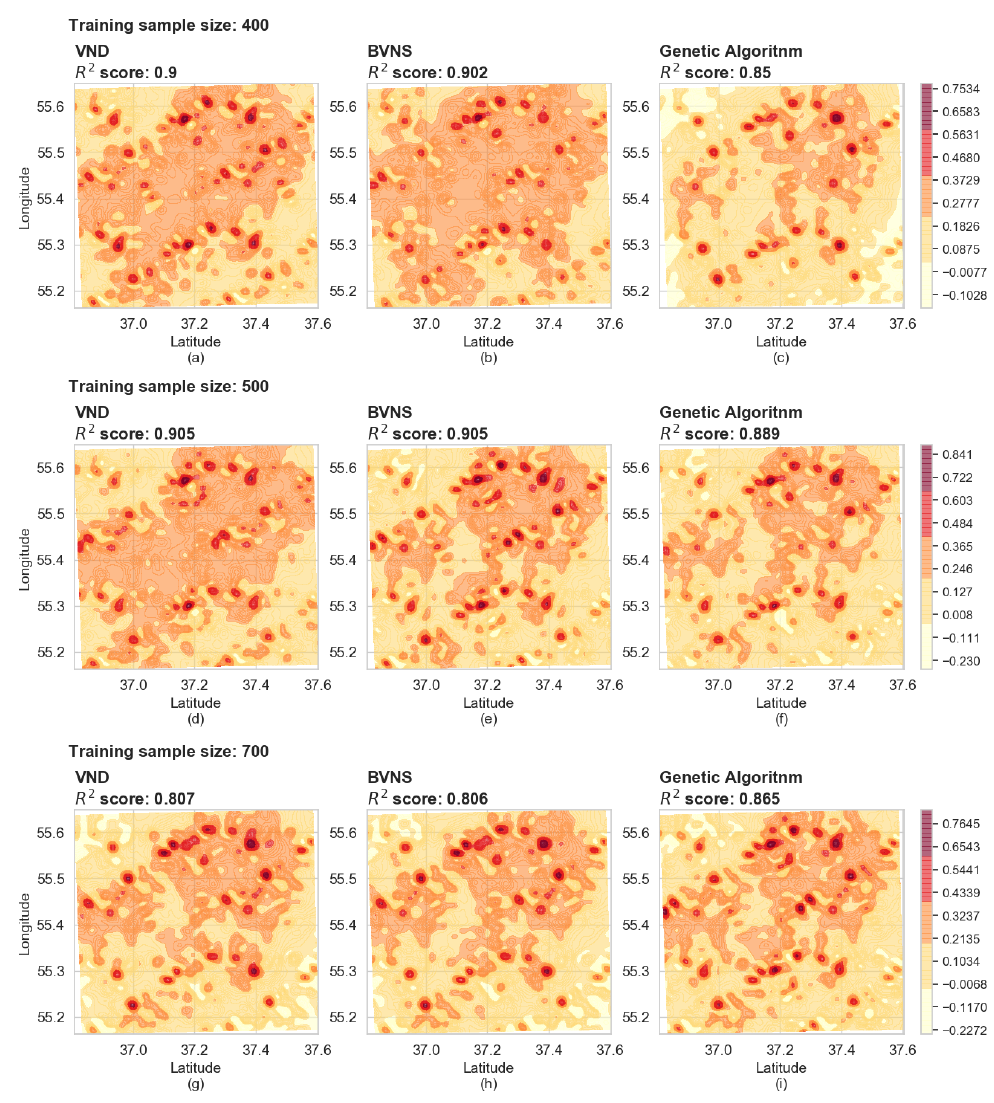
Figure 6. Spatial visualization of water quality index predictions made using Gaussian Process Regression. Training samples sets has sizes 400 ( a – c ), 500 ( d – f ) and 700 ( g – i ) sampling points. It can be noticed that predictions on 500 samples show better results than epy predictions on 700 samples. The best performance is obtained by VND on 500